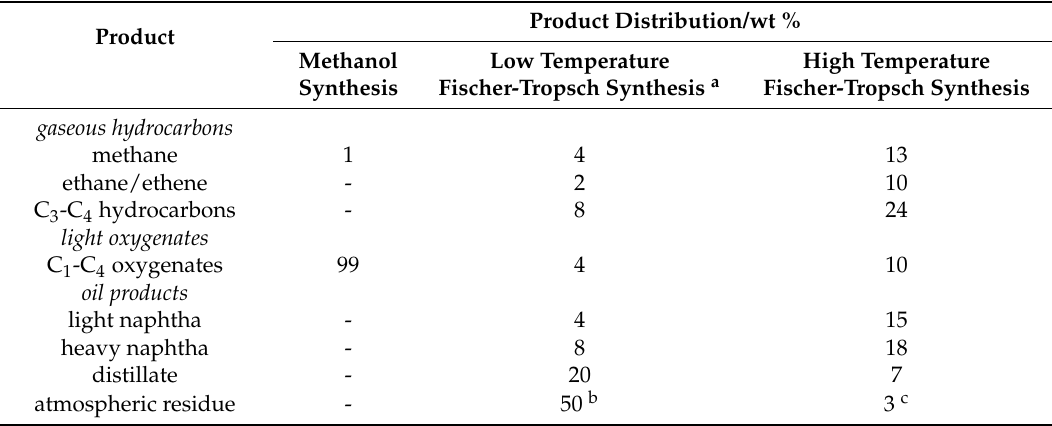
Table 2. Typical product distribution from different indirect liquefaction processes.